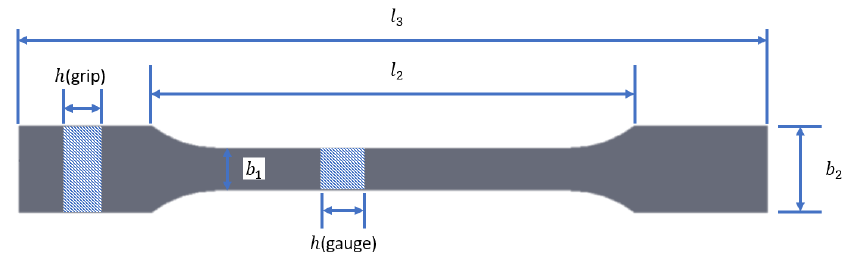
Figure 2. ISO 527-2 Type 1A tensile coupon and nomenclature.